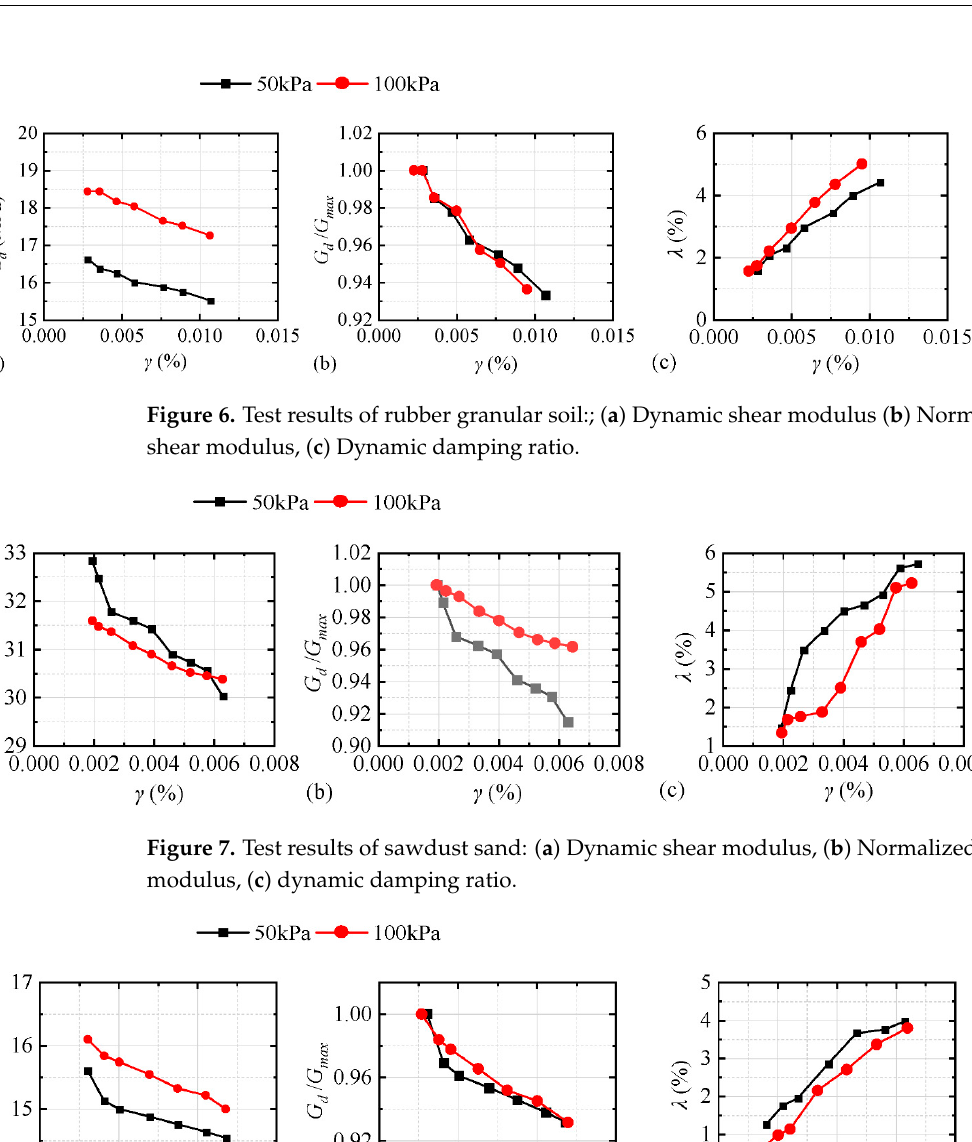
Figure 5. Test results of rubber powder soil: ( a ) Dynamic shear modulus, ( b ) Normalized dynamic